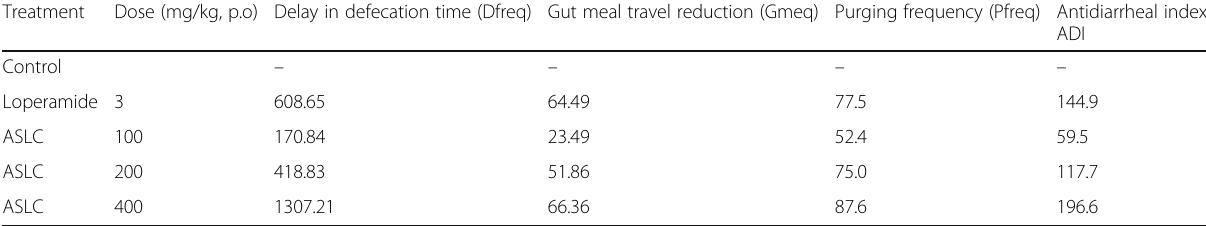
Table 5 In vivo anti-diarrheal index value of the aqueous stem extract of L. camara